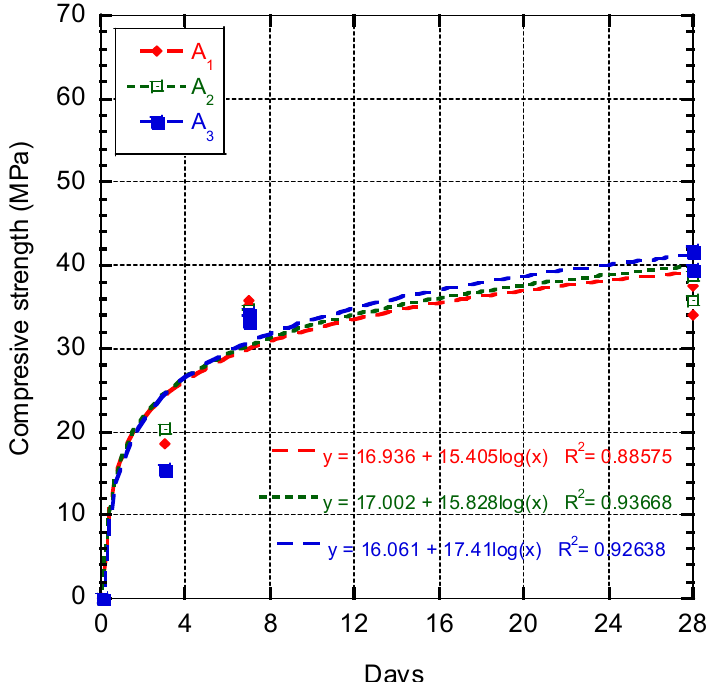
Figure 8. Compressive strength of basic concrete. Figure 9. Compressive strength of basic concrete.